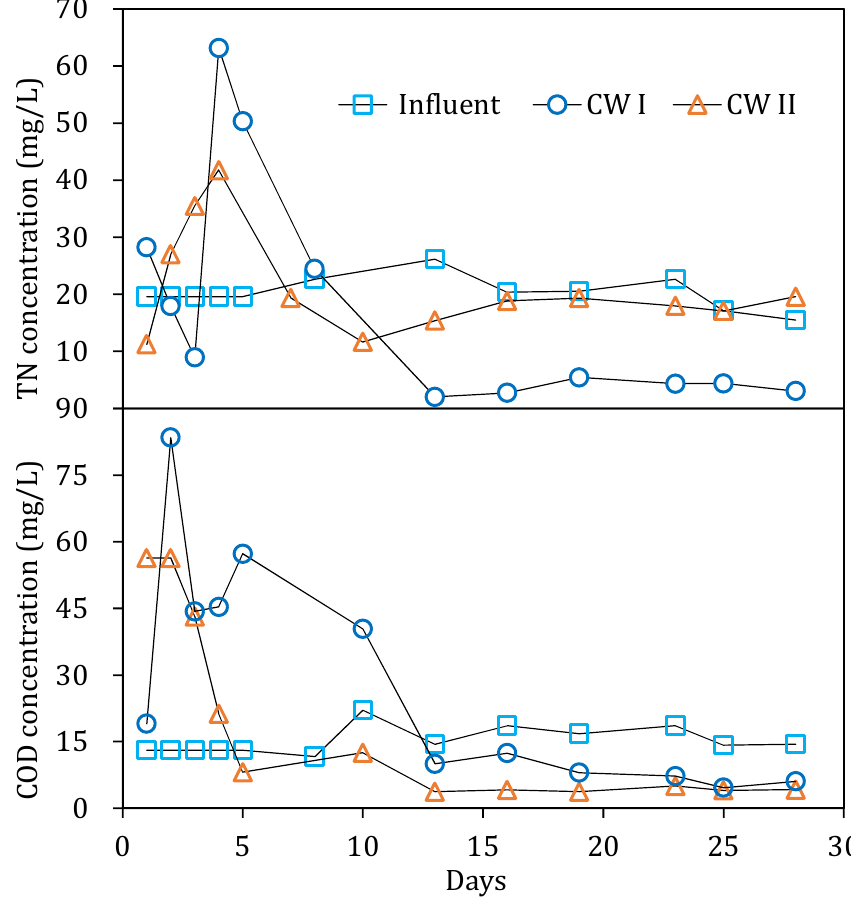
Figure 2. TN and COD content in the influent and effluent of two CWs in the first stage.